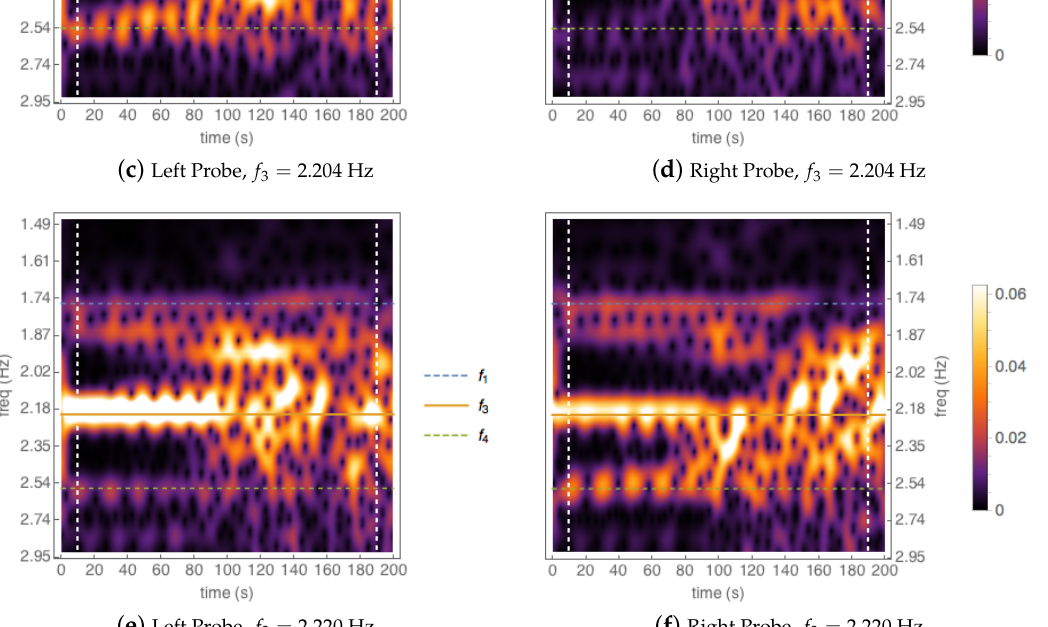
(cid:112) g | k | /2 π